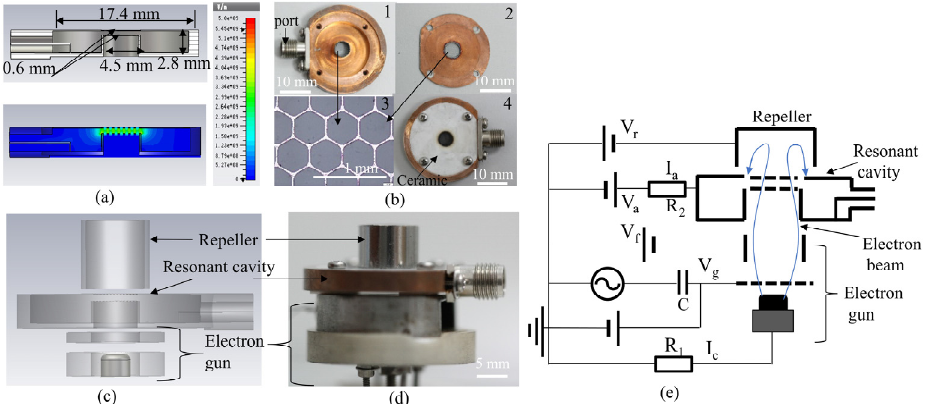
Figure 2. ( a ) The schematic diagram and simulation of the microwave electric field distribution in eigenmode of a re-entrant resonant cavity. ( b ) Photographs of the re-entrant resonant cavity. Images 1 and 2: lower and top plate of the cavity. Image 3: the close-up of the grid. Image 4: the assembled resonant cavity. ( c ) Schematic diagram of the reflex klystron oscillator structure. ( d ) The optical image of the klystron oscillator structure assembled. ( e ) Electrical scheme of measurement setup of a klystron oscillator